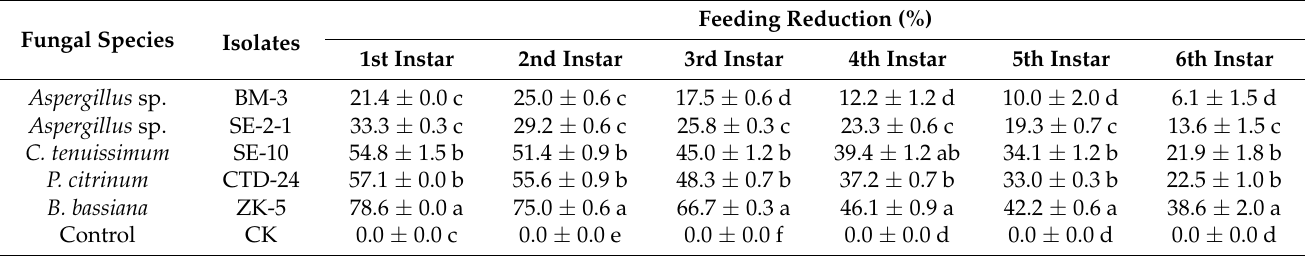
Table 9. Effects of fungal isolates on feeding performance of the sixth instar S. frugiperda larvae at 1 × 10 8 conidia mL − 1 . Feeding Reduction (%) Fungal Species Isolates 1st Instar 2nd Instar 3rd Instar 4th Instar 5th Instar 6th Instar Aspergillus sp. BM-3 Aspergillus sp. SE-2-1